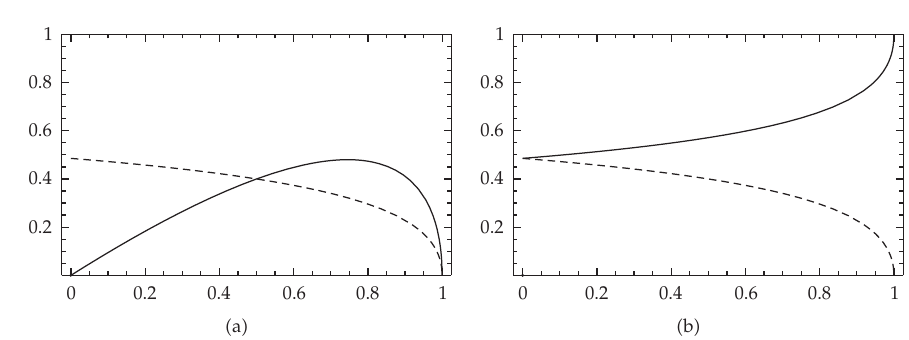
Figure 1: The Gini curve G F (cid:3) p (cid:4)(cid:3) dashed; (cid:3) a (cid:4) and (cid:3) b (cid:4)(cid:4) , the weighted Gini curve g F (cid:3) p (cid:4)(cid:3) solid; (cid:3) a (cid:4)(cid:4) , and the Zenga curve Z F (cid:3) p (cid:4)(cid:3) solid; (cid:3) b (cid:4)(cid:4) in the Pareto case with x 0 (cid:7) 1 and θ (cid:7) 2 . 06.